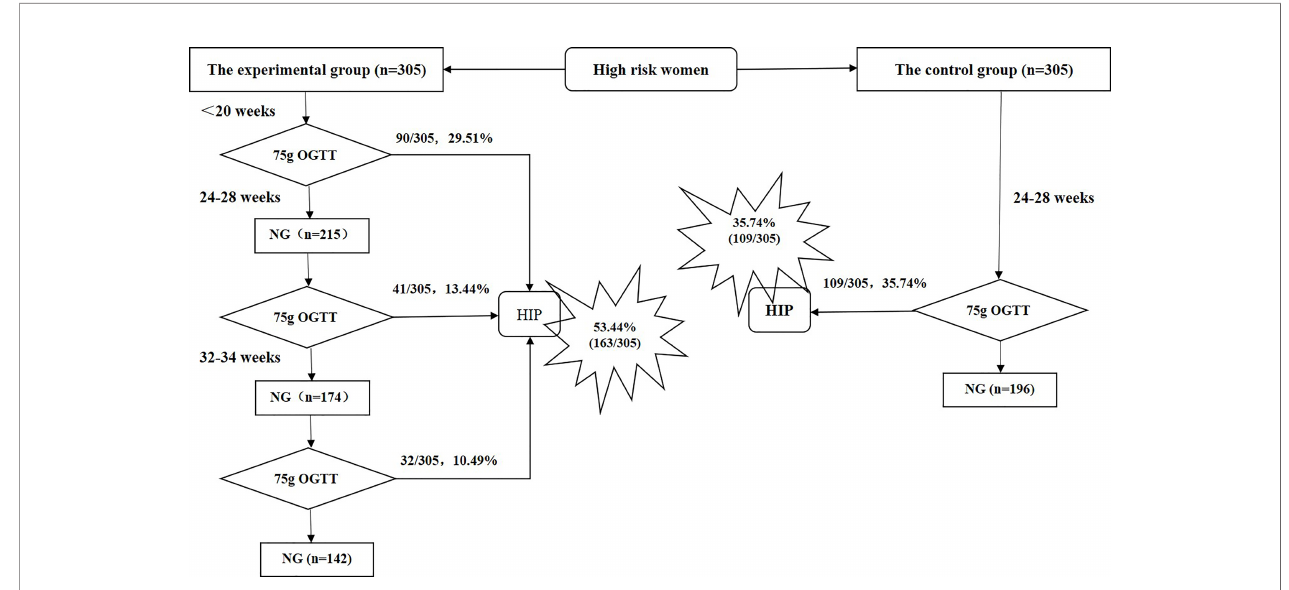
FIGURE 1 | Screening period and hyperglycemia in pregnancy diagnosis in the experimental and control groups. NG, normal glucose; OGTT, oral glucose tolerance test; HIP, hyperglycemia in